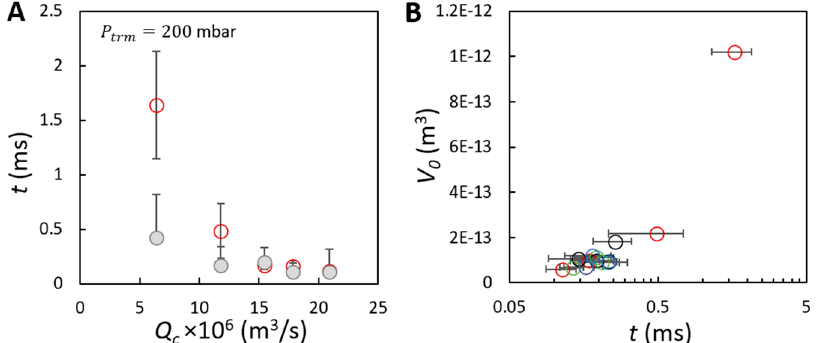
Figure 6. Two timescales for bubble formation at the membrane surface. ( A ) Bubble growing time (O) and the interval time ( ) as a function of the continuous phase flow rate. ( B ) Average volume of initial bubbles as a function of the bubble growing time for the effects of Q c (O), P trm (O), c (O) and η (O). The bubble volumes correspond to that presented in Figure 4A–C. The two timescales are derived based on 30 bubble formation events, focusing on bubble formation from three positions in the field of view of the membrane in the video recorded at a frame rate of 20,000 frames per second. The final bubble size reflects a balance between bubble formation and bubble